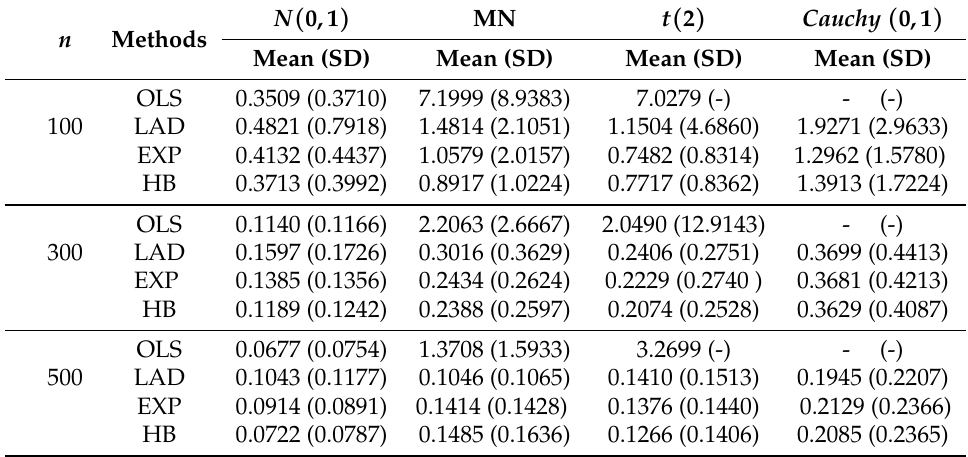
Table 3. The mean (SD) of IMSE 2 for ˆ g ( · ) under different error distributions and sample sizes.